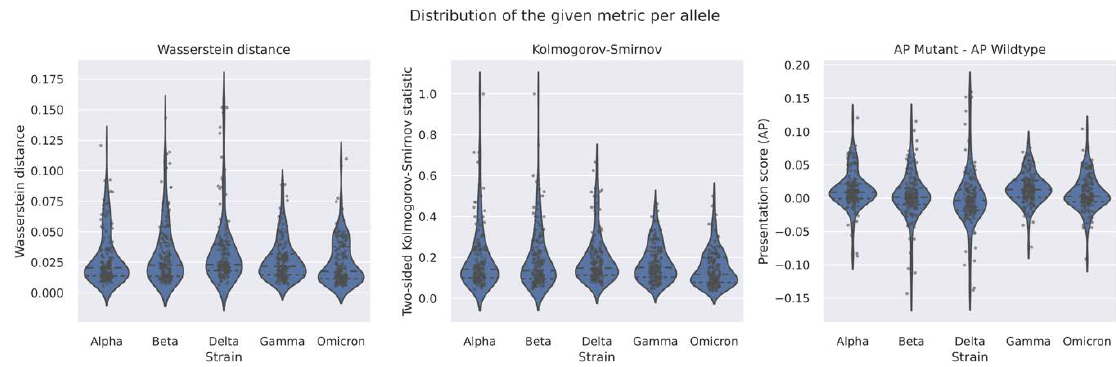
Figure 2. Violin plots of the distributions of the Wasserstein distance, two-sided Kolmogorov– Smirnov statistic, and average difference in AP score between mutant and wildtype epitopes across the HLA alleles, for each VOC. The dashed lines within each violin represent the quartiles and the dots show the score for each metric for each epitope.